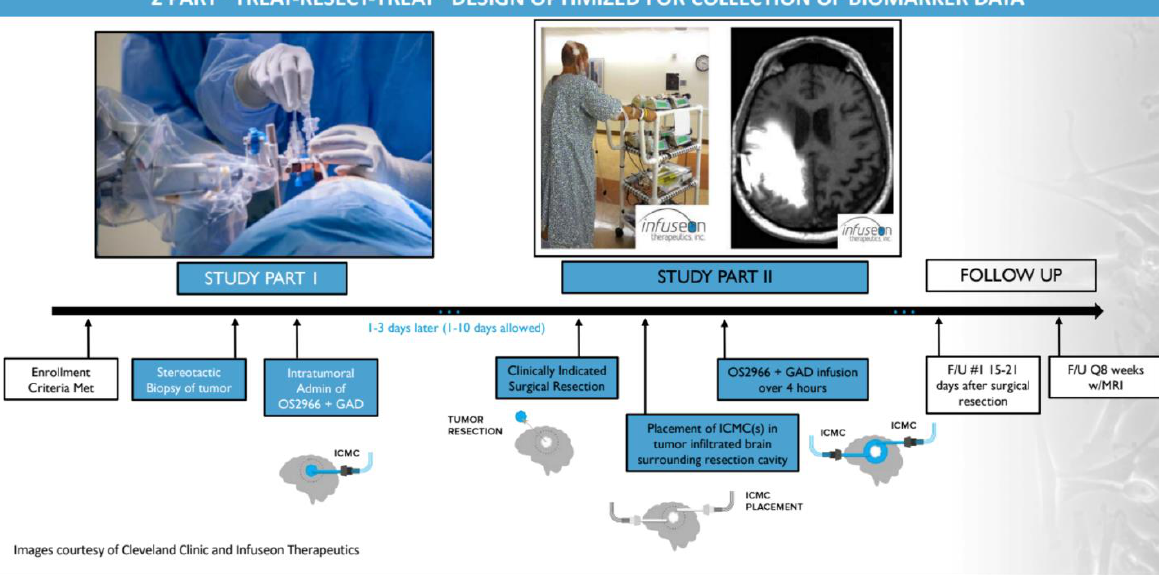
Figure 2. This schematic depicts the 2-staged approach with OS2966 treatment. In Study Part 1, patients will receive a single intratumoral infusion of OS2966 directly to the contrast-enhancing bulk tumor (“intratumoral administration”) by CED using the ICMC. In Study Part 2, the same patients will undergo a clinically indicated surgical resection of the previously infused tumor within 1 to 10 days (optimally within 1 to 3 days) following completion of the first OS2966 infusion. Immediately following surgical resection, 2 ICMCs will be placed directly into the surrounding non-enhancing tumor-infiltrated brain, and perioperative infusion of OS2966 will take place over 4 h (“intraparenchymal administration”). To confirm the overall quality of OS2966 delivery, a 2-mM concentration of gadoteridol (ProHance ® , a gadolinium contrast agent used to visualize the infusion) will be added to OS2966 before each infusion in order to enable real-time MRI use during the infusion procedures. F/U = follow up; GAD = gadolinium; ICMC = Infuseon Cleveland Multiport Catheter.